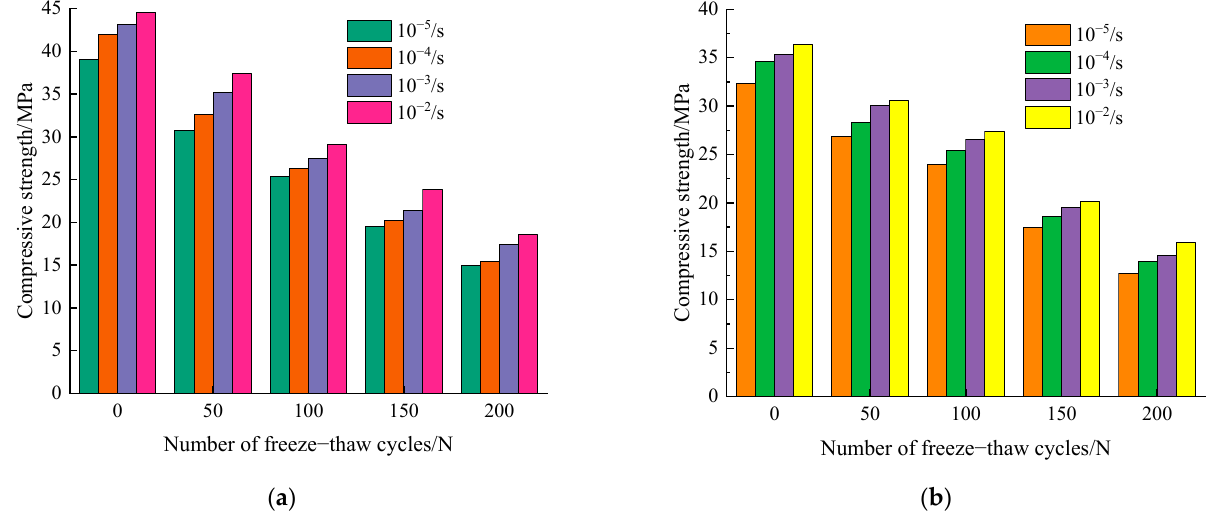
Figure 11. Dynamic compressive strength with different freeze–thaw cycles. ( a ) w/c = 0.45 and ( b ) w/c = 0.55.